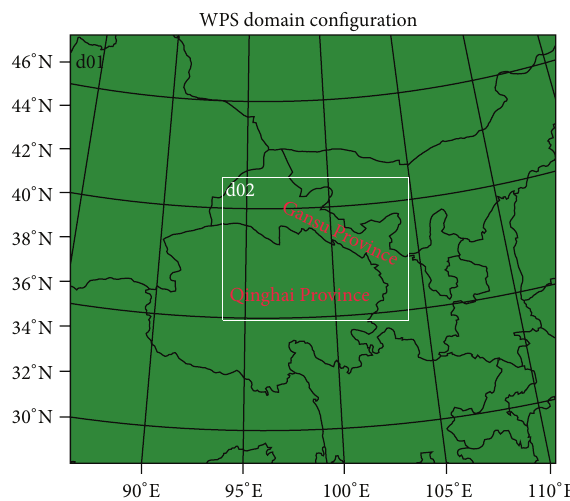
Figure 1: Domains for the ARW-WRF forecasts. The outer box is the coarse grid with a resolution of 12 km (d01); the inner box is the nested grid (d02) with a resolution of 4